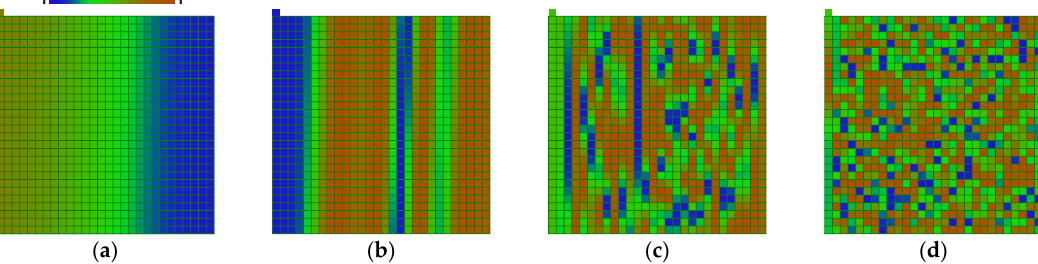
Figure 6. The distribution shape of the weights of the matrix W 1 for p = 6 ( a ), p = 10 ( b ), p = 15 ( c ), p = 25 ( d ) for LogNNet-784:25:10 and r = 1.885.